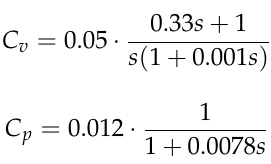
Figure 10. Disturbance attenuation of the four methods.